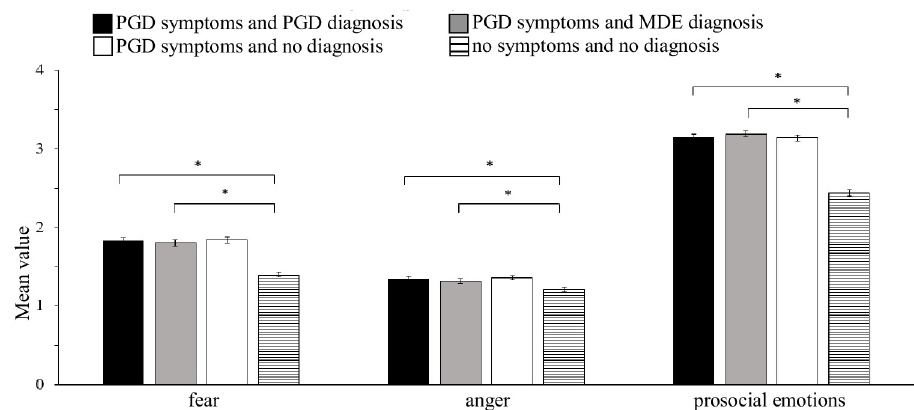
Fig 2. Mean scores and standard error of the mean value by mental health condition for emotional responses. Note. Of the five a priori specified contrasts (C1-C5), only significant contrasts are indicated by brackets. ( � adj. p < .01 (Bonferroni-Holm), F -